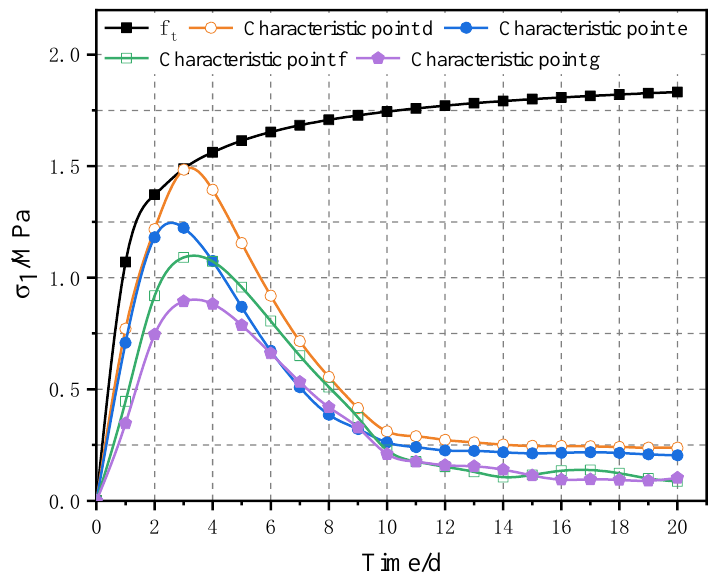
Figure 8. Stress duration curves of characteristic points d, e, f and g.